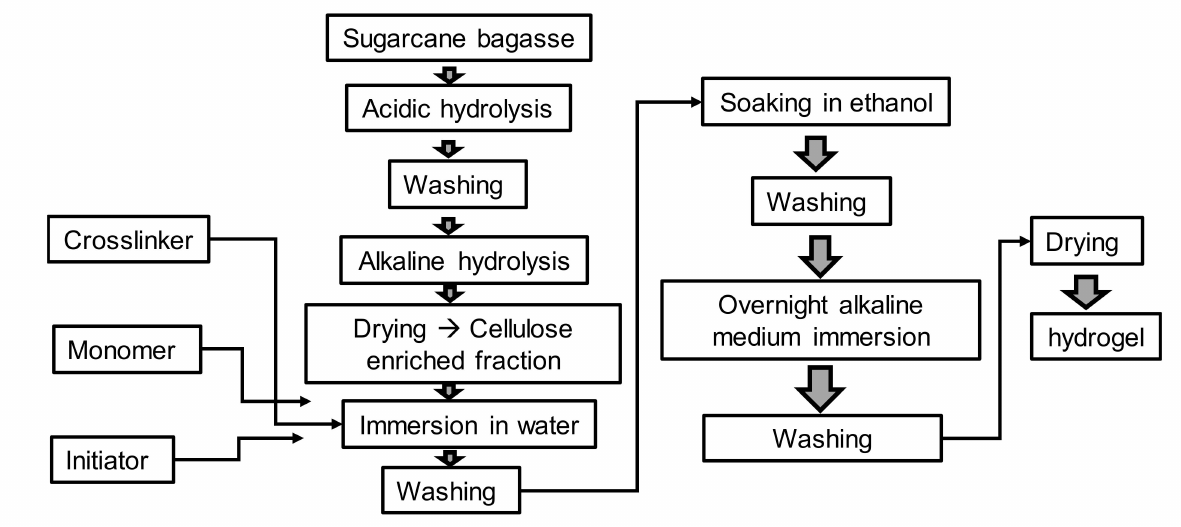
Scheme 1. Schematic diagram of hydrogel preparation from sugarcane bagasse-based